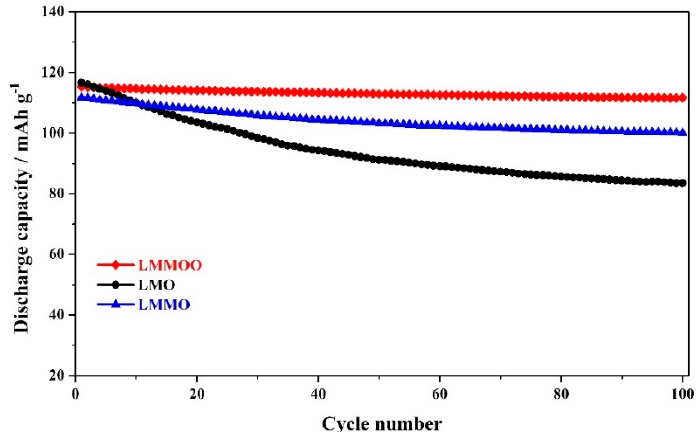
Figure 3. Initial charge–discharge curves of the LiMn 2 O 4 , LiMn 1.95 Mg 0.05 O 4 , and octahedral LiMn 1.95 Mg 0.05 O 4 samples at 1.0 C.